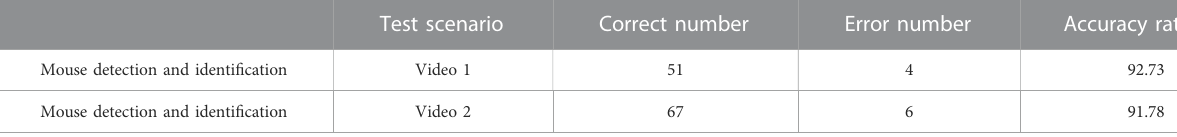
TABLE 5 Performance of the foreign body detection model.